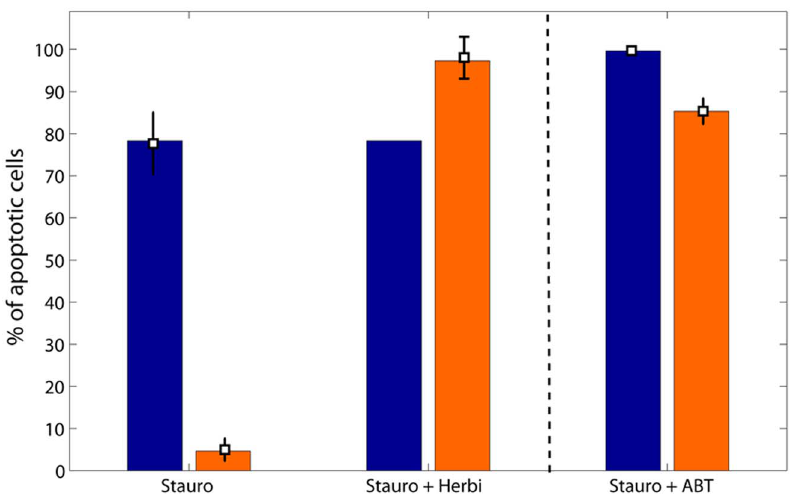
Figure 6. Apoptosis in parental (blue) and Src-transformed (orange) NIH-3T3 cells. Bars represent simulations of the calibrated model of mitochondrial apoptosis. Experimental datapoints for staurosporine given as a single agent or combined with herbimycin were used for parameter estimation. They are reprinted from [5]. Datapoints for the combination of staurosporine with ABT-737 are original data and were used for model validation.